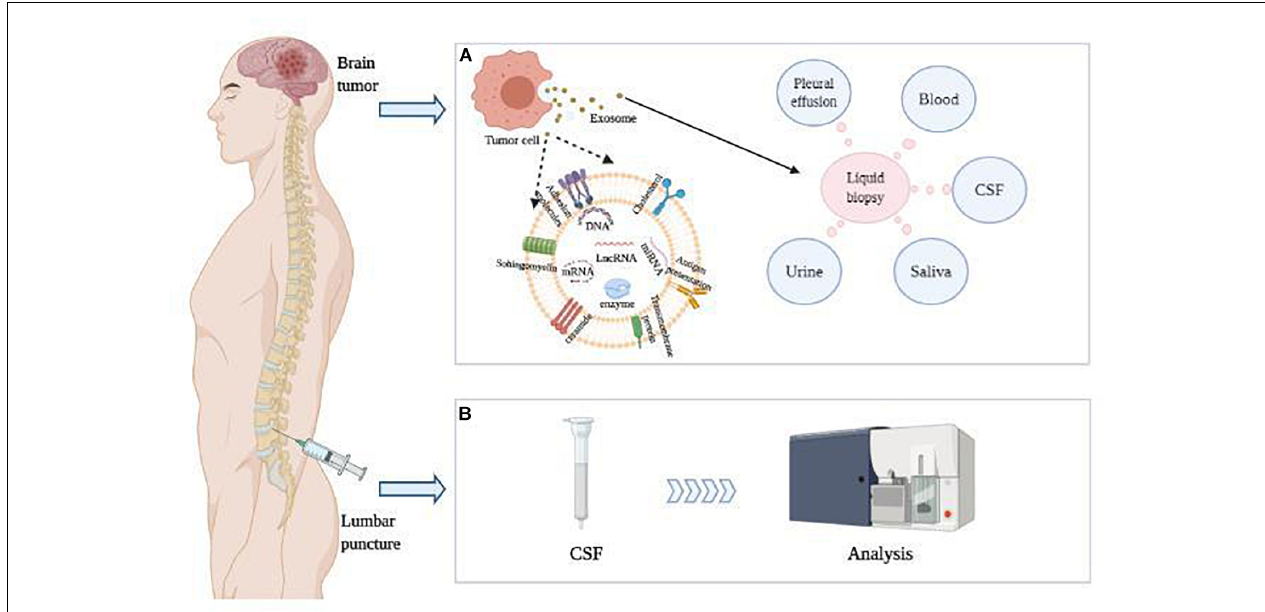
FIGURE 1 | LncRNA in CSF were detected as diagnostic and prognostic indicators of brain tumors. (A) Brain tumor cells release exosomes containing nucleic acids, which can be further detected in various body fluids. (B) CSF was obtained by lumbar puncture, and CSF lncRNAs packaged in exosomes were detected as diagnostic and prognostic indicators of brain